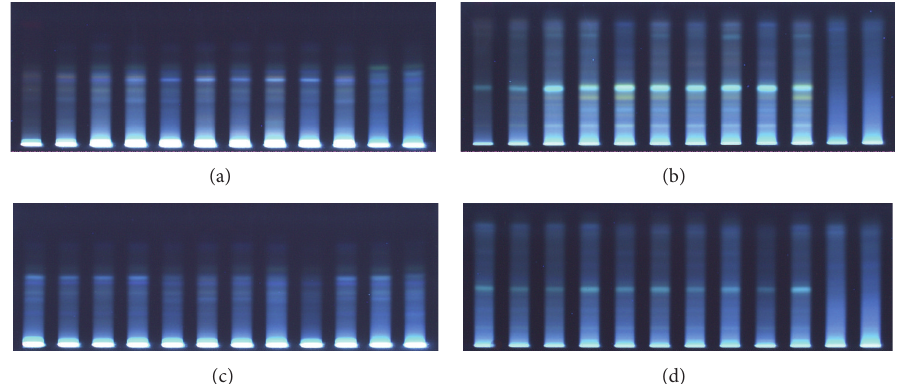
Figure 1: HPTLC chromatograms of maize extracts for ZP 434 (a, b) and ZP 704 (c, d) hybrids obtained in CS1 and CS2, respectively. Chromatograms sequence on each plate corresponds to sample order in Table 1.